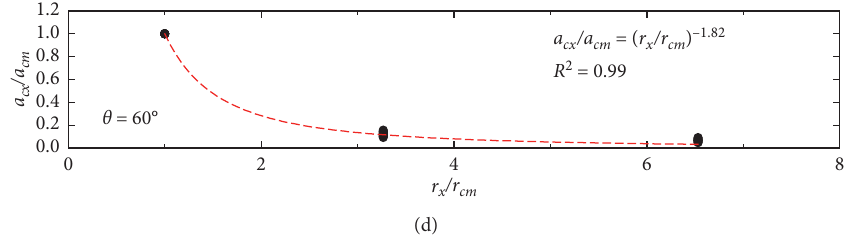
Figure 12: The attenuation law wave crest amplitude in meandering reach.